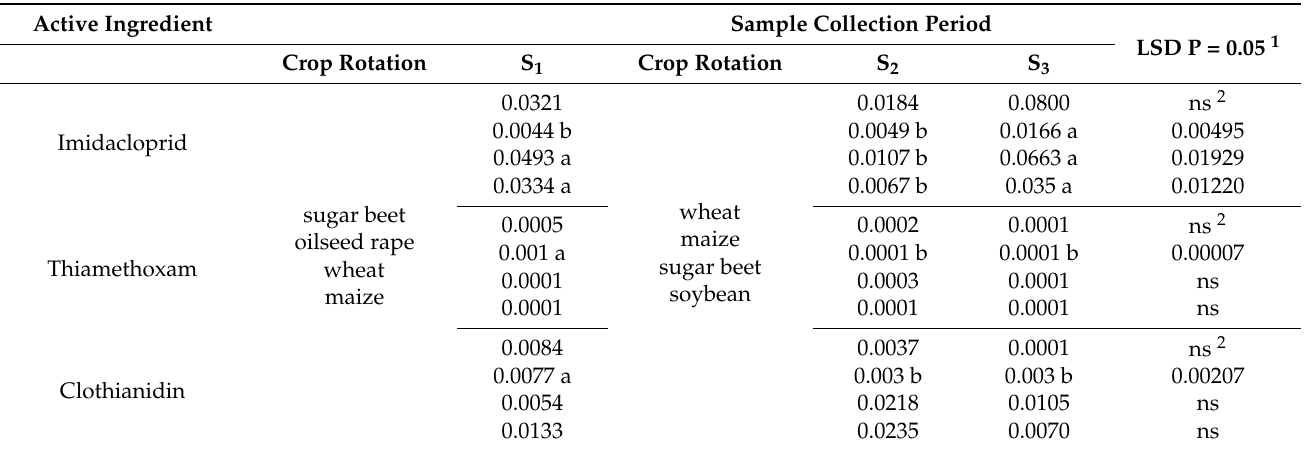
Table 3. Determined residues of neonicotinoids (in mg/kg) in earthworm samples from fields with different crop rotations in